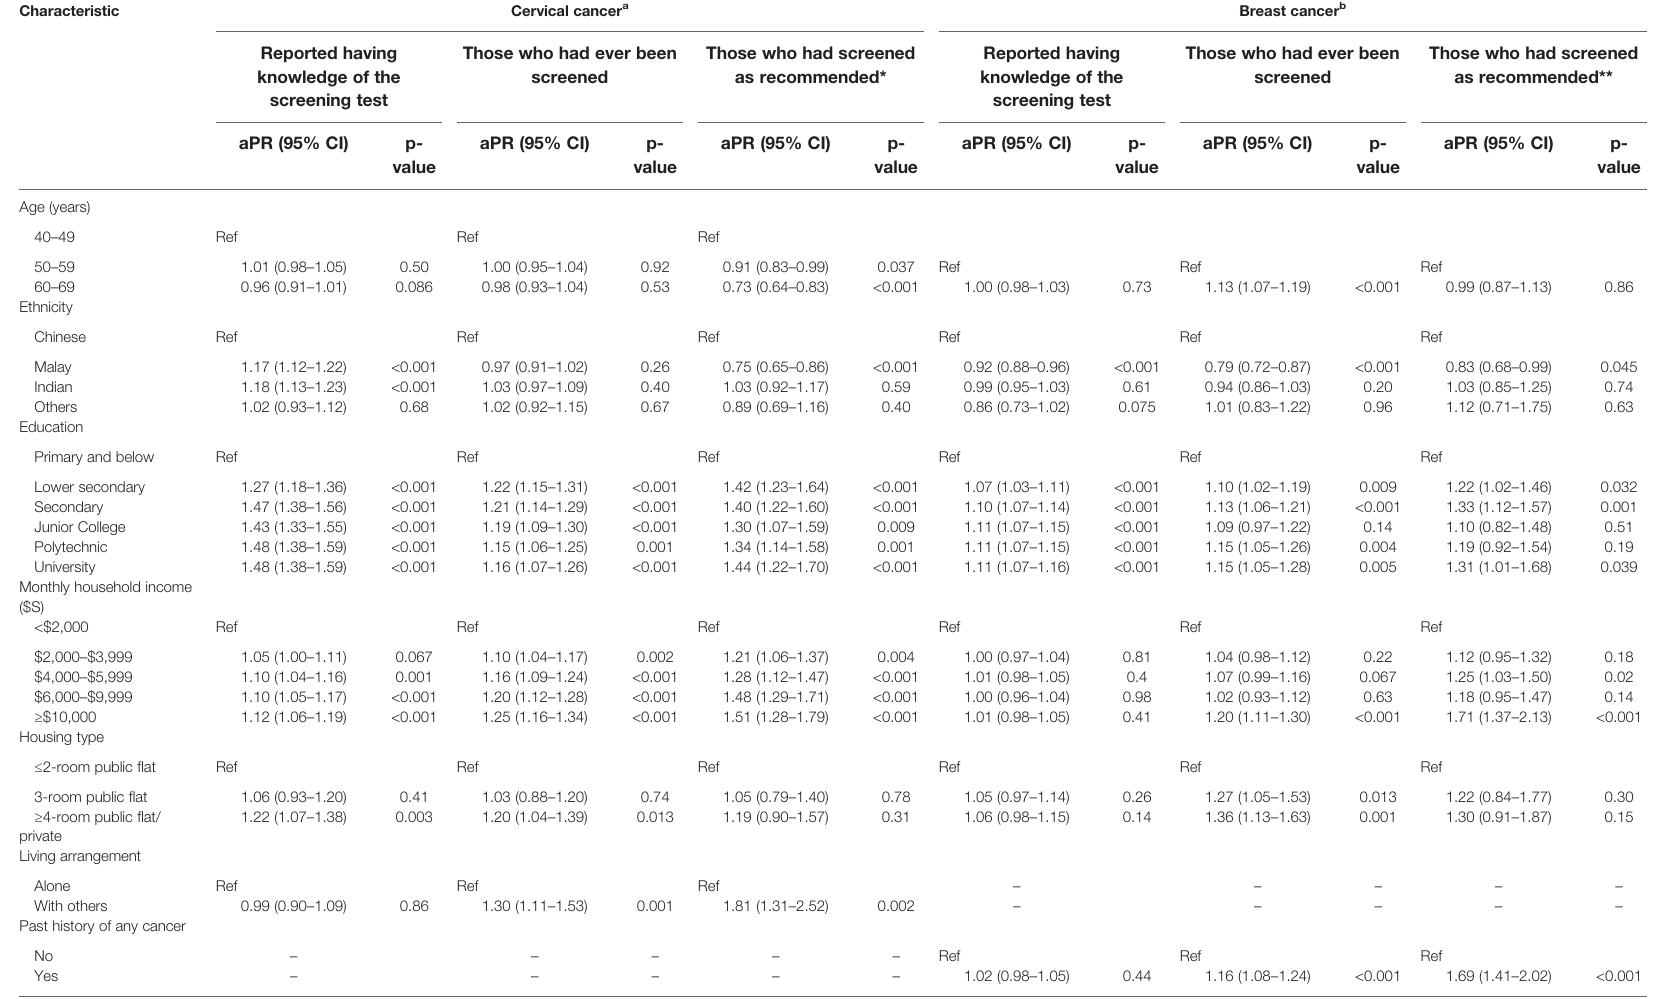
TABLE 3 | Adjusted prevalence ratio (aPR) estimates for characteristics associated with knowledge of and participation in cervical and breast cancer screening.